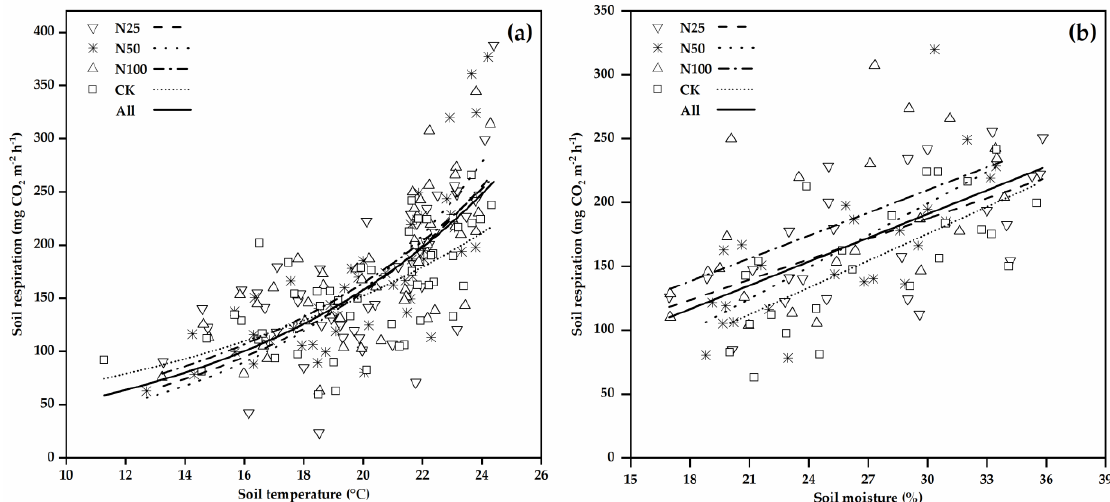
Figure 4. Relationships between R S and soil temperature ( a ) and soil moisture ( b ) under different N treatments. Each data point represents the mean of three technical replicates. N25, N50, N100, and CK represent 25, 50, 100, and 0 kg N ha −1 a −1 N addition treatments, respectively. Table 3. Parameters of different regression models between R S , soil temperature (T), and soil moisture (W).